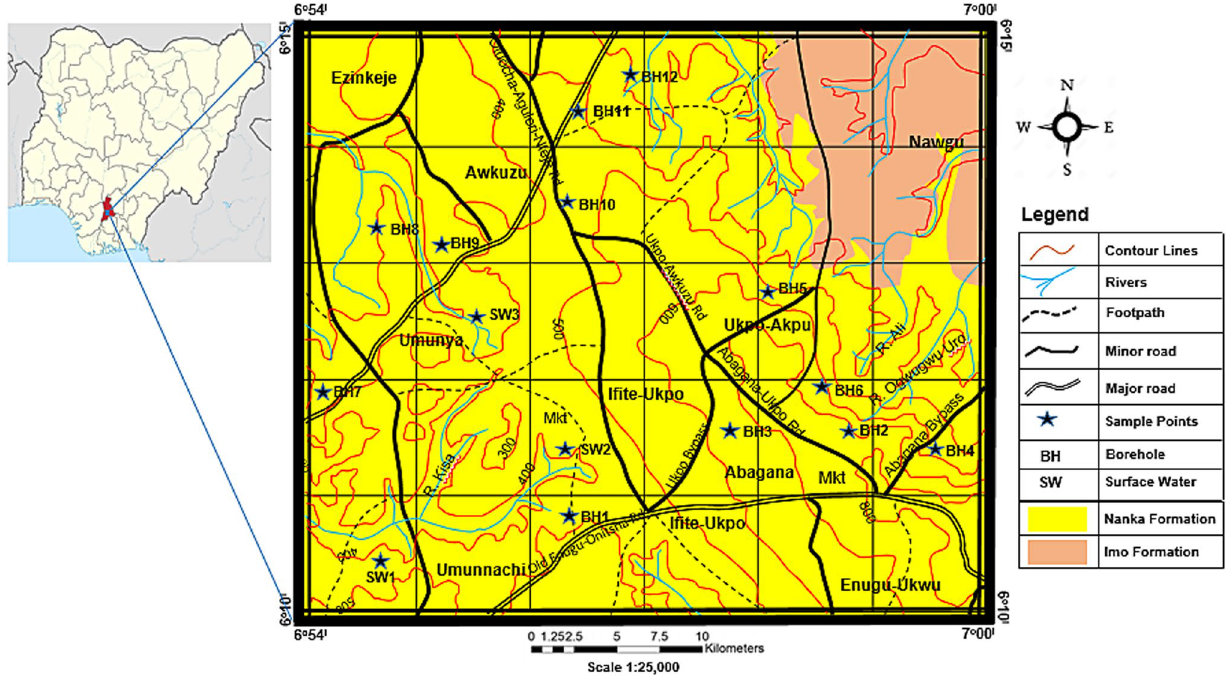
Fig. 1 Map showing the location, geology, accessibility and drainage of the study